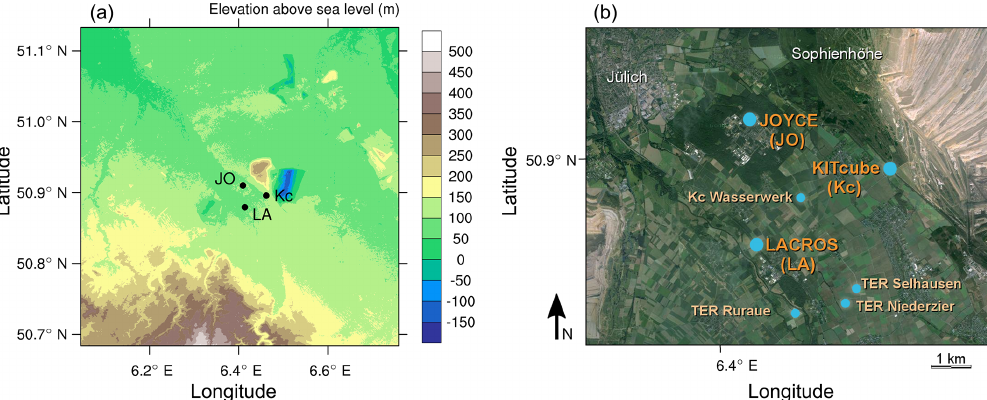
Figure 1. Location of different measurement sites during the HOPE campaign. The abbreviations JOYCE (JO), LACROS (LA) and KITcube (Kc) denote the three principal measurement sites Jülich Observatory for Cloud Evolution, Leipzig Aerosol and Cloud Remote Observations System, and the Karlsruhe Institute of Technology cube, respectively. Panel (a) shows the topography in a 50km × 50km do- main centered around JOYCE (source: ASTER GDEM Validation Team (2011)) and (b) provides a closer view of the HOPE measurement sites (source: Google Maps). Additional surface flux measurements were taken at the Kc site Wasserwerk (Kc Was) and the TERENO (TER) sites Ruraue (TER Rur), Selhausen (TER Sel) and Niederzier (TER